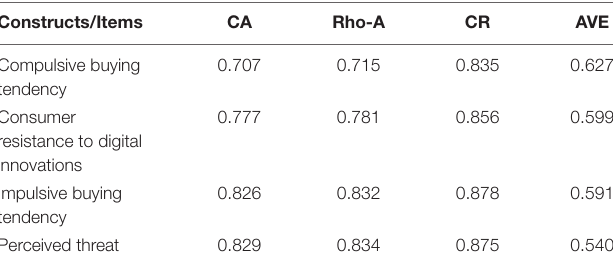
TABLE 2 | Composite reliability, Cronbach’s alpha, and AVE values.